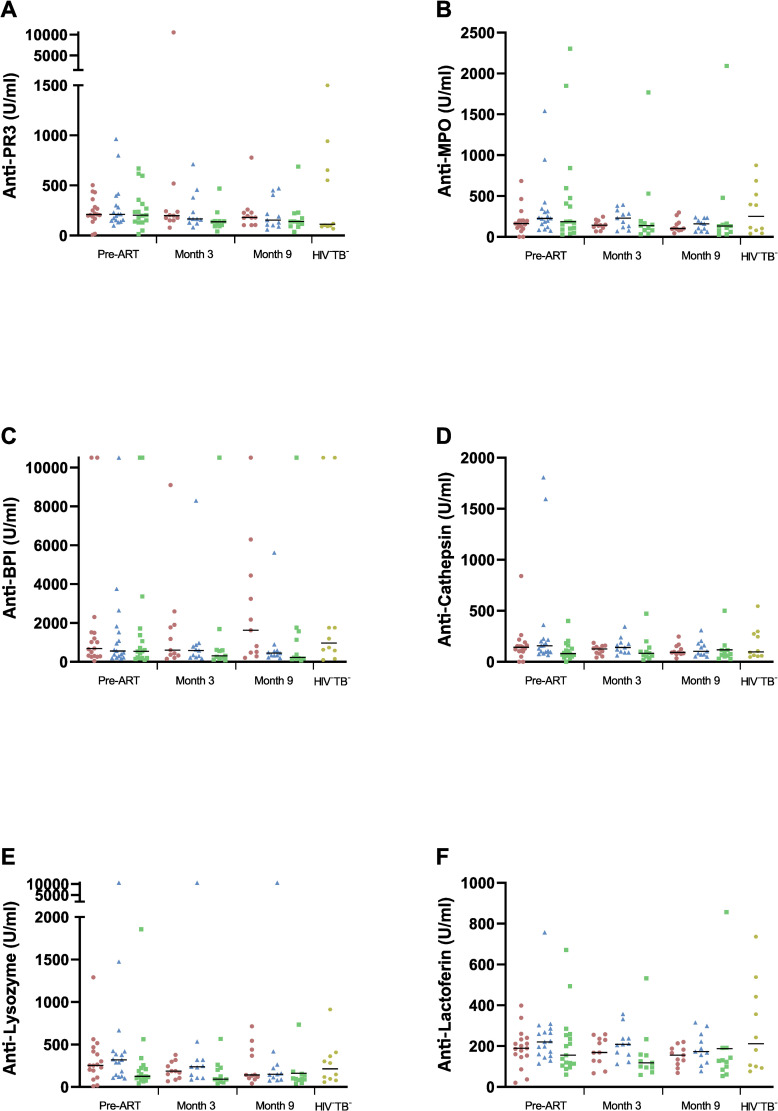
Plasma levels of other ANCAs in TB-IRIS patients and controls.Graphs show a comparison between TB-IRIS patients (red circles), HIV+TB+ (blue triangles), HIV+TB- (green squares), and HIV-TB- (yellow hexagons) in the median plasma levels of anti- PR3 (A), -MPO (B), -BPI (C), -cathepsin (D), -lysozyme (E), and -lactoferin (F) (U/ml) measured prior to ART, and at 3 months and 9 months of ART. Analysis were performed between all groups at each time point using Kruskal-Wallis tests, with Dunn’s post-hoc test, and the level of significance set to P < 0.05. Non-significant p-values have been omitted from the graphs, as no significant values were observed.